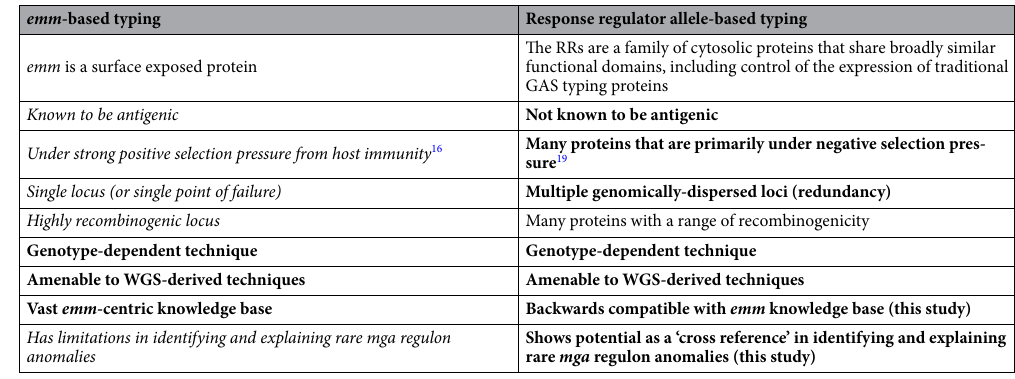
Table 4. Comparison of properties of the emm -based and response regulator-based typing systems of group A Streptococcus . Preferred (bold) and non-preferred (italics) properties of a molecular bacterial typing